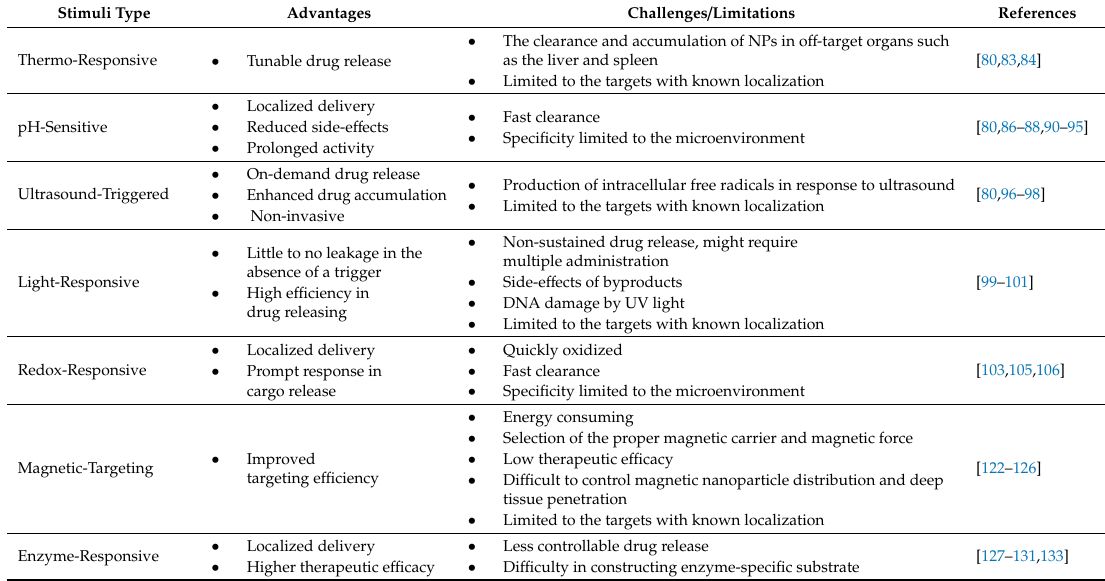
Table 2. Summary of di ff erent stimuli-responsive